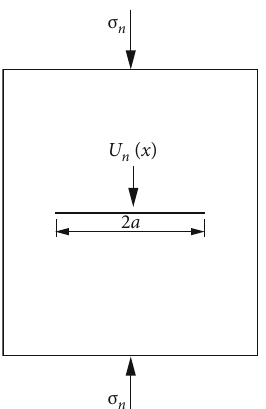
Figure 2: Sketch of mechanical analysis of fracture in compression